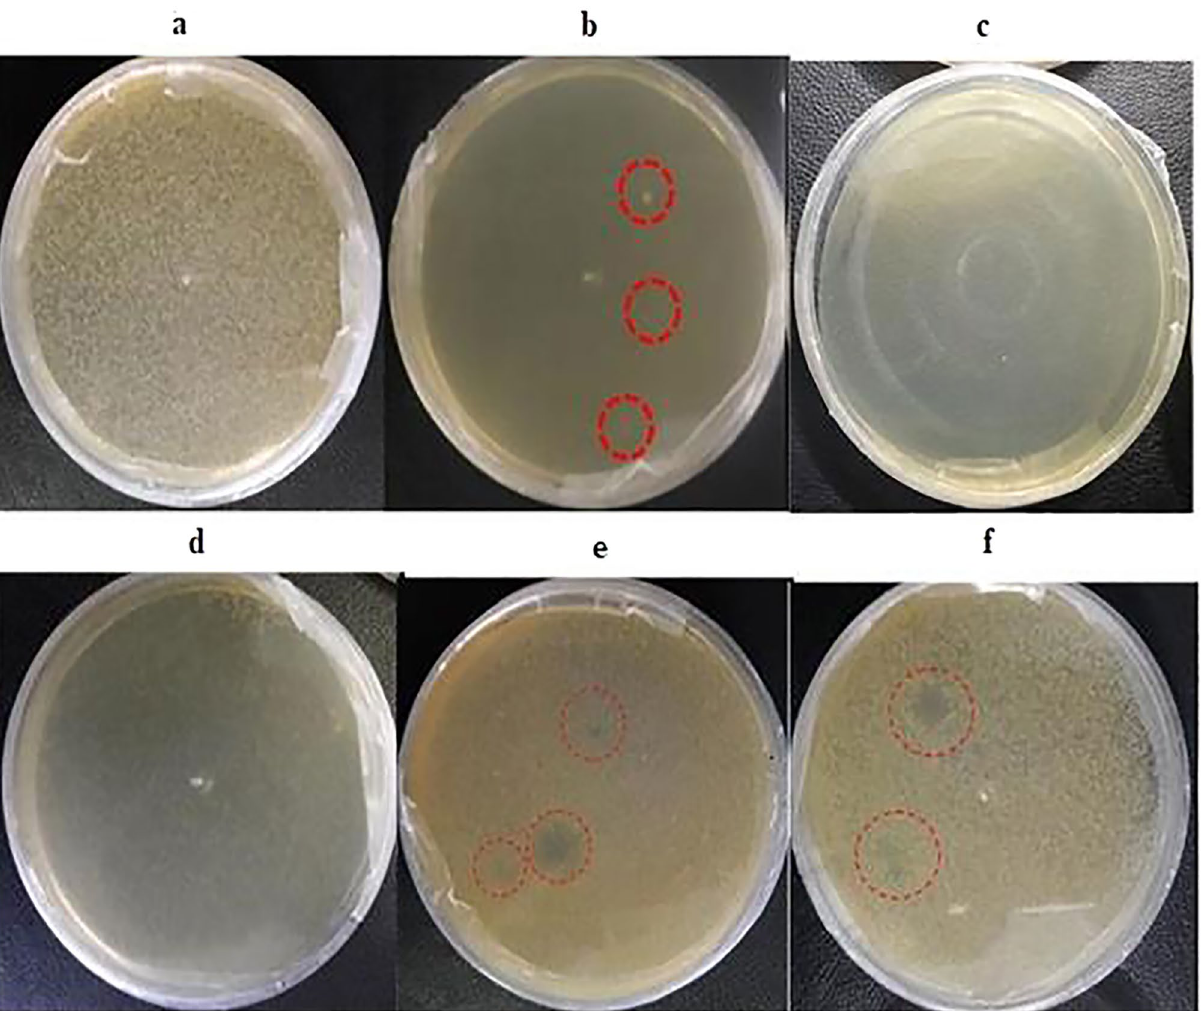
Figure 4. The effect of bacteriophage amount on the growth inhibition of E. coli . ( a ) The absence of bacteriophage in the culture medium. ( b ) The E. coli plus 200 μL of bacteriophage in the culture media and the growth of only 2–3 bacterial colonies in the entire medium. ( c ) Use of a maximum of 2000 μL of bacteriophage in the culture medium without the bacterial growth. ( d ) The bacterial culture with 5 μL of bacteriophage in the medium and bactericidal inhibition growth. ( e ) The presence of bacteriophage in the medium as a result of reduction of the number of centrifuges into two turns, and plaque formation in the culture medium. ( f ) The use of concentrated bacteriophage and double centrifuge, and plaque